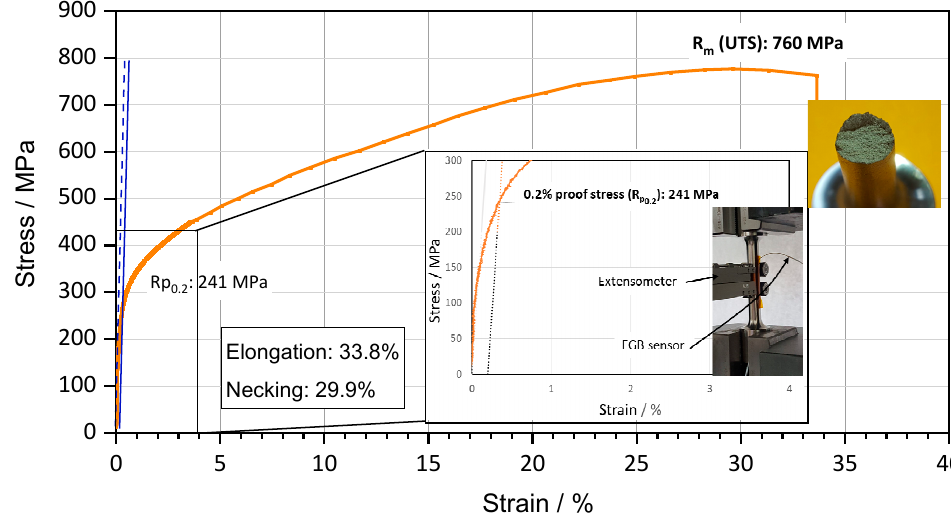
Figure 13. Stress–strain characteristic curve of Fe-28Mn-6Si-5Cr alloy in pre-strained state. A detail of the extensometer and the FBG sensor placed on the sample is inserted, together with a picture that illustrates the fracture surface at the end of the test.